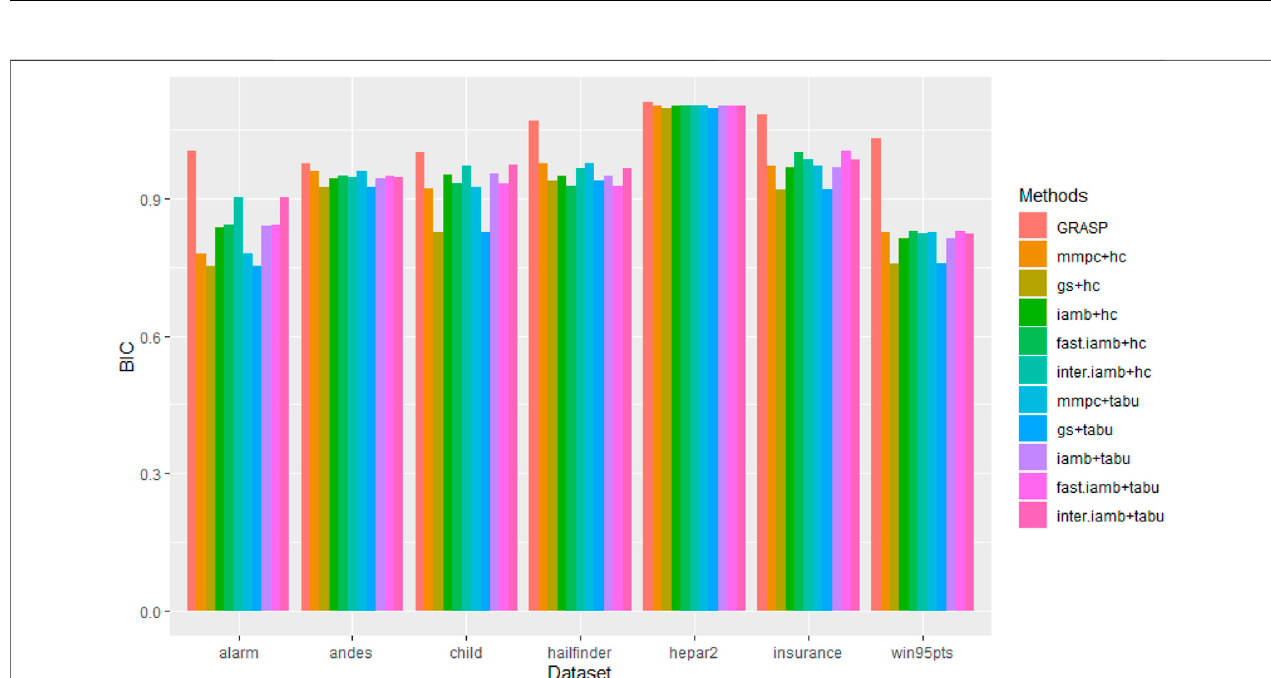
FIGURE 3 | BIC scores of all methods on seven benchmark networks with observation size 1,000. GRASP has higher BIC scores for all the benchmark networks.